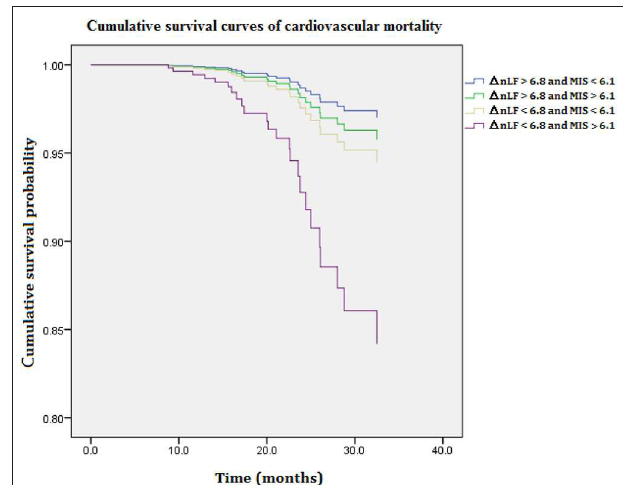
FIGURE 2 | Cumulative survival curves of cardiovascular mortality with respect to different categories of 1 nLF and MIS score after adjusting for age, diabetes mellitus, CAD, MIS score, and 1 nLF during 5097.6 person-months of follow-up. Combined lower levels of 1 nLF ( < 6.8 nu) and higher levels of MIS score ( > 6.1 nu) was associated with a highest risk of cardiovascular mortality ( P = 0.041). CAD, coronary artery diseases; MIS, malnutrition-inflammation syndrome; 1 nLF (%), changes in normalized low frequency before and after hemodialysis.